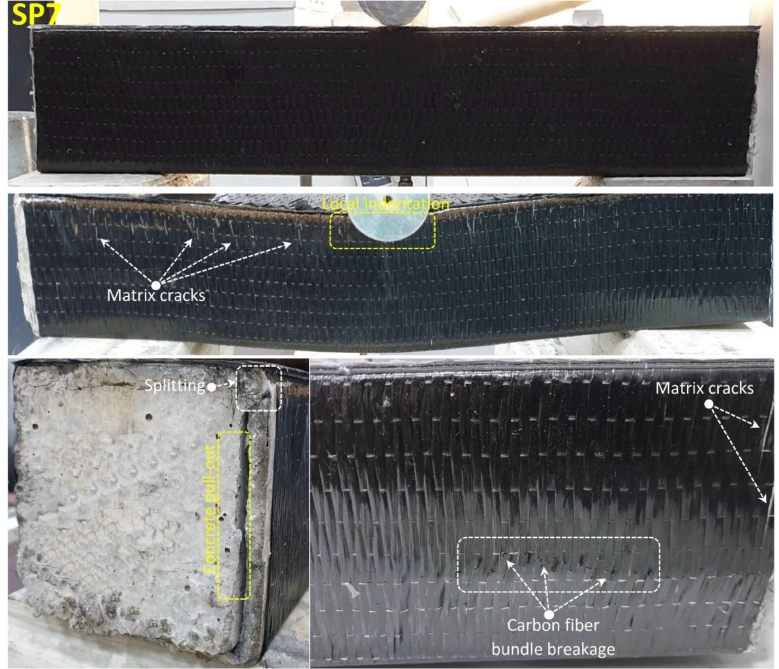
Figure 16. Undamaged and damaged specimen images of